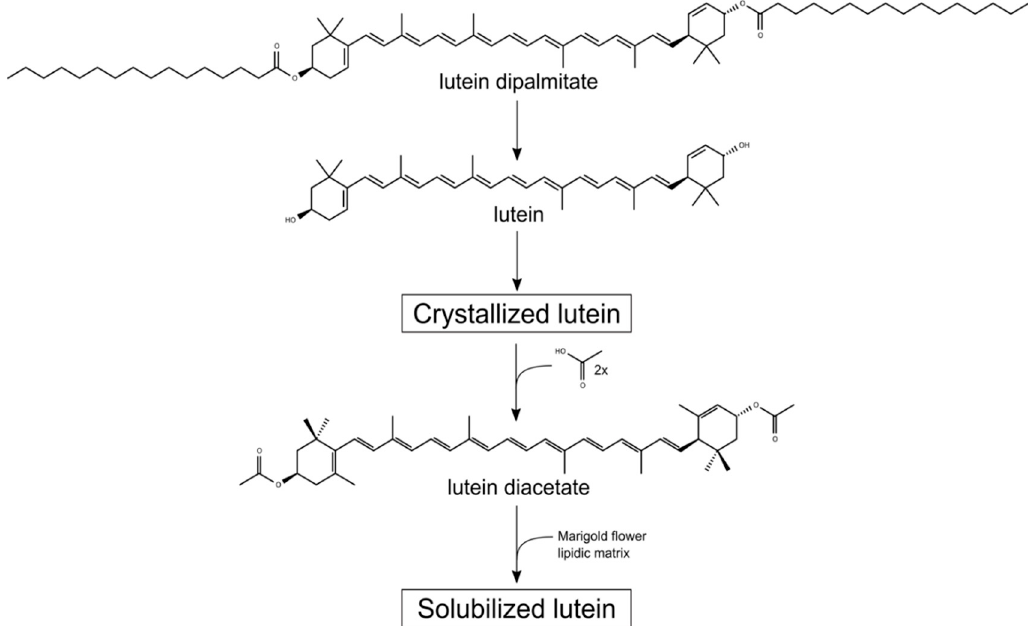
Figure 1. Formation of lutein (L) from marigold flower as free L (microcrystals) and as a diacetate derivative. In the flower, L is present as esterified L with fatty acids. To extract this carotenoid, it is de-esterified and purified by crystallisation. To solubilise these crystals and facilitate absorption in the digestive system, L and other xanthophyll carotenoids (XCs) can be re-esterified with acetate or propionate upon crystallisation and re-suspended in the flower’s lipid matrix with added surfactants to maintain the XCs solubilised under ambient conditions.